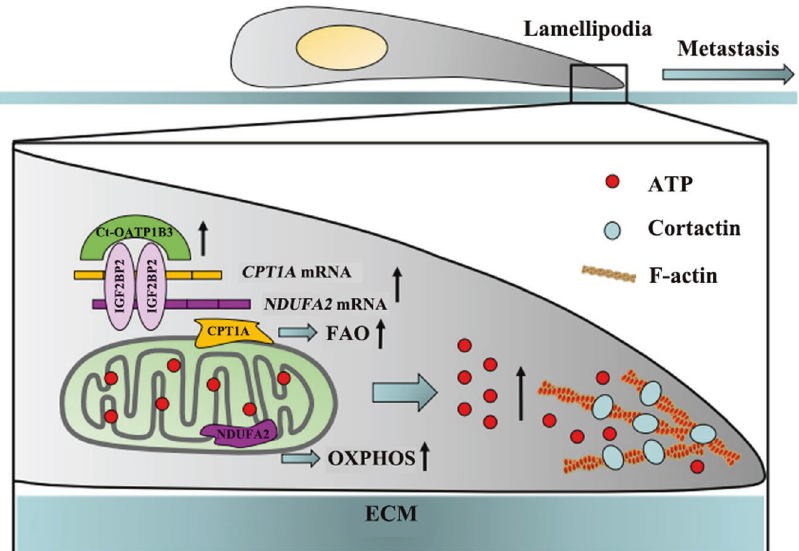
Fig. 8 Schematic of the function and mechanism of Ct-OATP1B3 in HGSOC metastasis. Ct-OATP1B3 directly interacts with IGF2BP2 and increases the expression of CPT1A and NDUFA2, which enhances the FAO and OXPHOS activities and ATP production, thus leading to the lamellipodia formation and HGSOC cell migration and